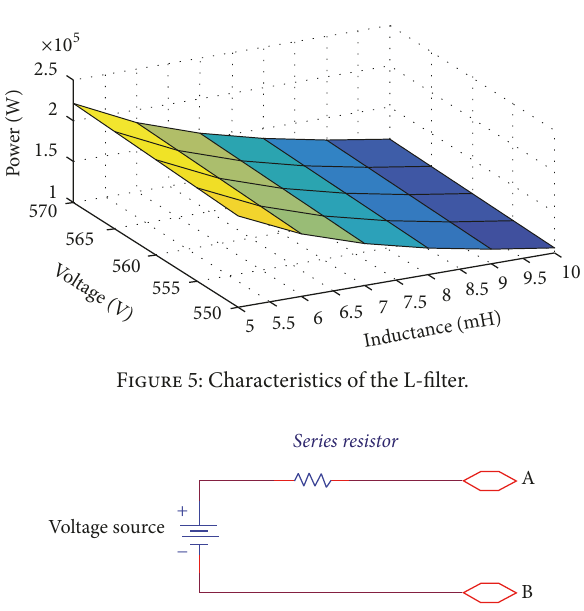
Figure 6: Thevenin source implemented to test SB 1700E inverter.